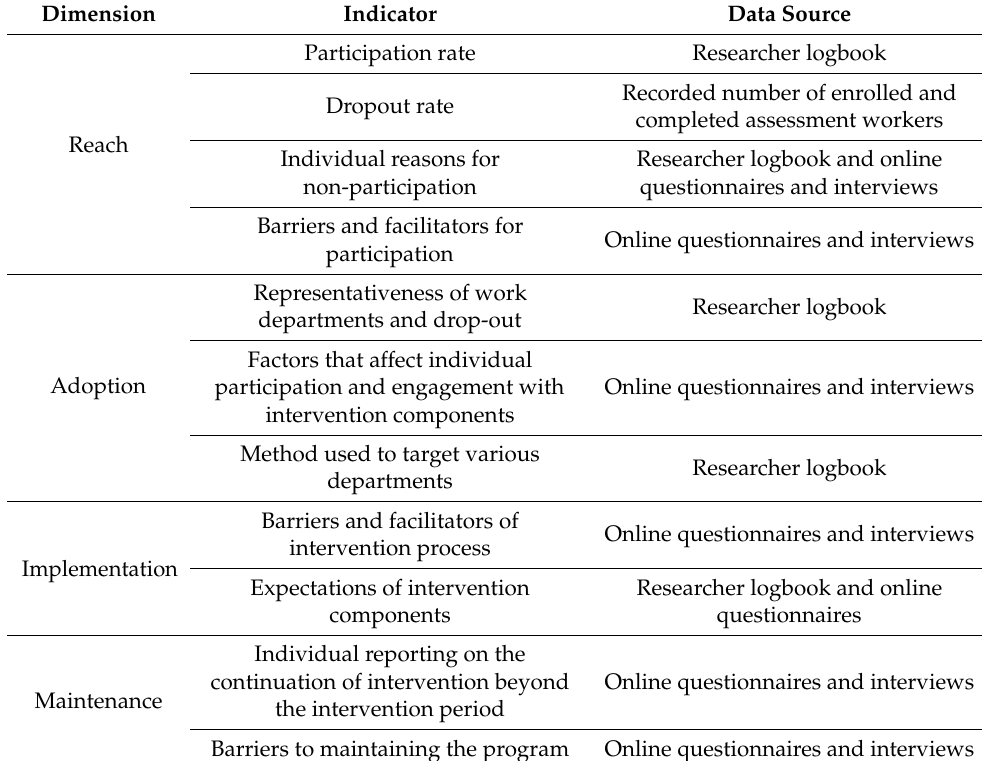
Table 1. Process evaluation measures and data sources using the RE-AIM